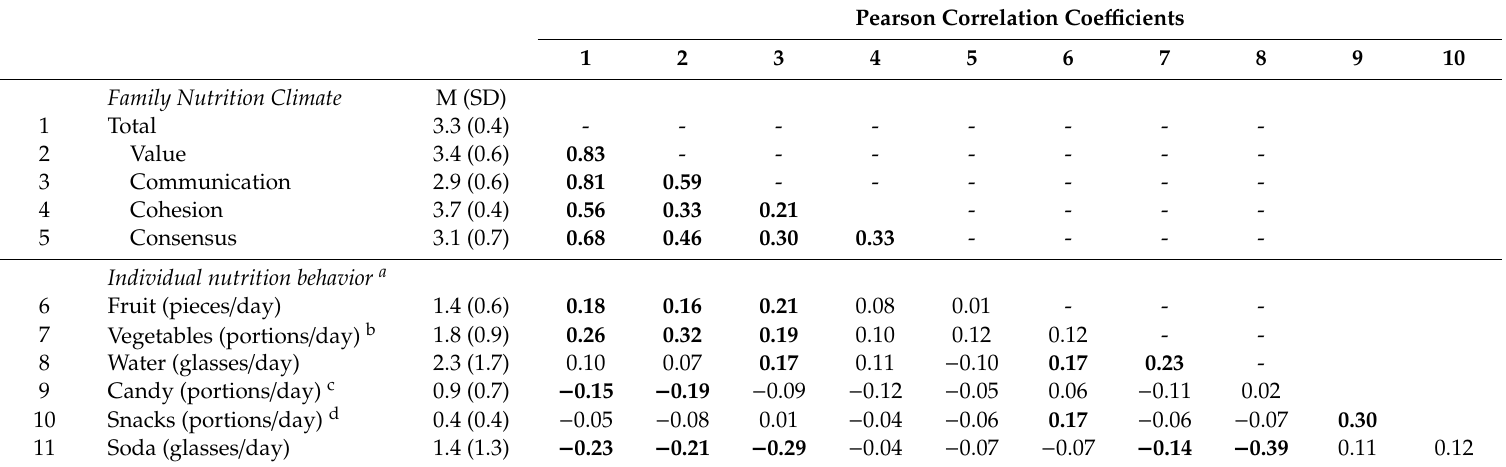
Table 2. Correlation coe ffi cients between family nutrition climate and the child’s individual nutrition behavior.